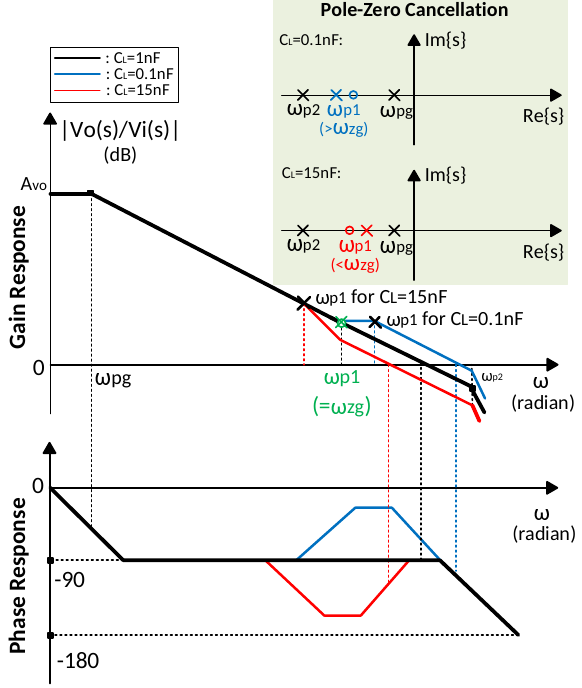
Figure 6. Bode plots of pole-zero cancellation with a 0.1–15-nF load capacitance, precise pole-zero cancellation occurs at C L = 1